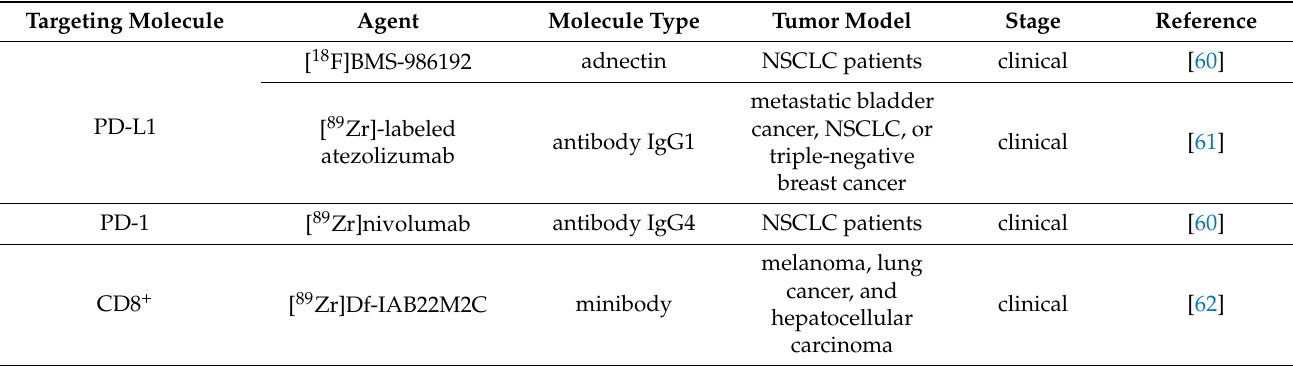
Table 2. Most relevant radiotracers tested in clinical